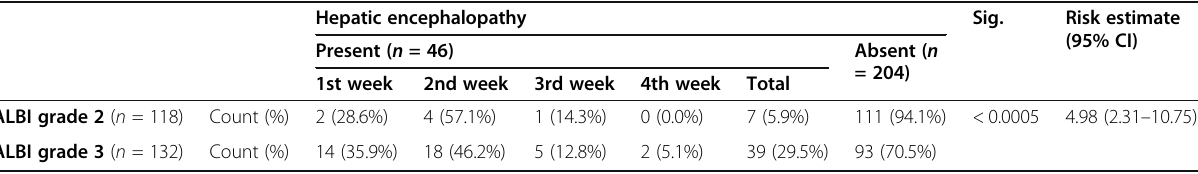
Table 2 ALBI grades versus hepatic encephalopathy cross-tabulation Hepatic encephalopathy Sig.